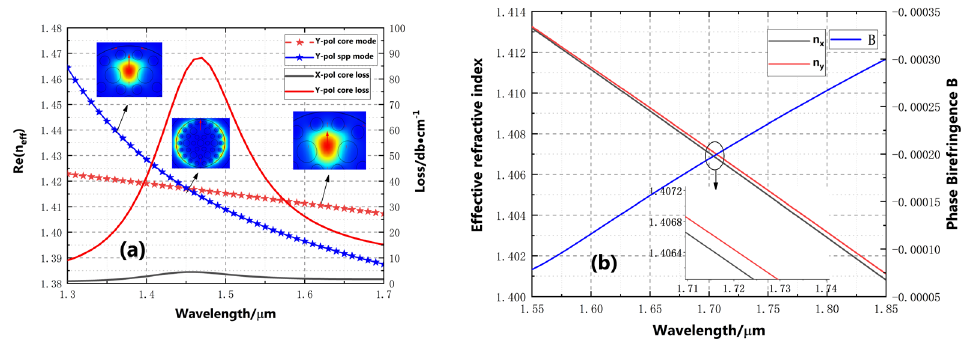
Figure 3. ( a ) The variation of effective refractive index and loss with wavelength for different modes. ( b ) The variation of n x , n y and phase birefringence B with wavelength for the core modes. The variation in the phase birefringence coefficient of the core mode versus the